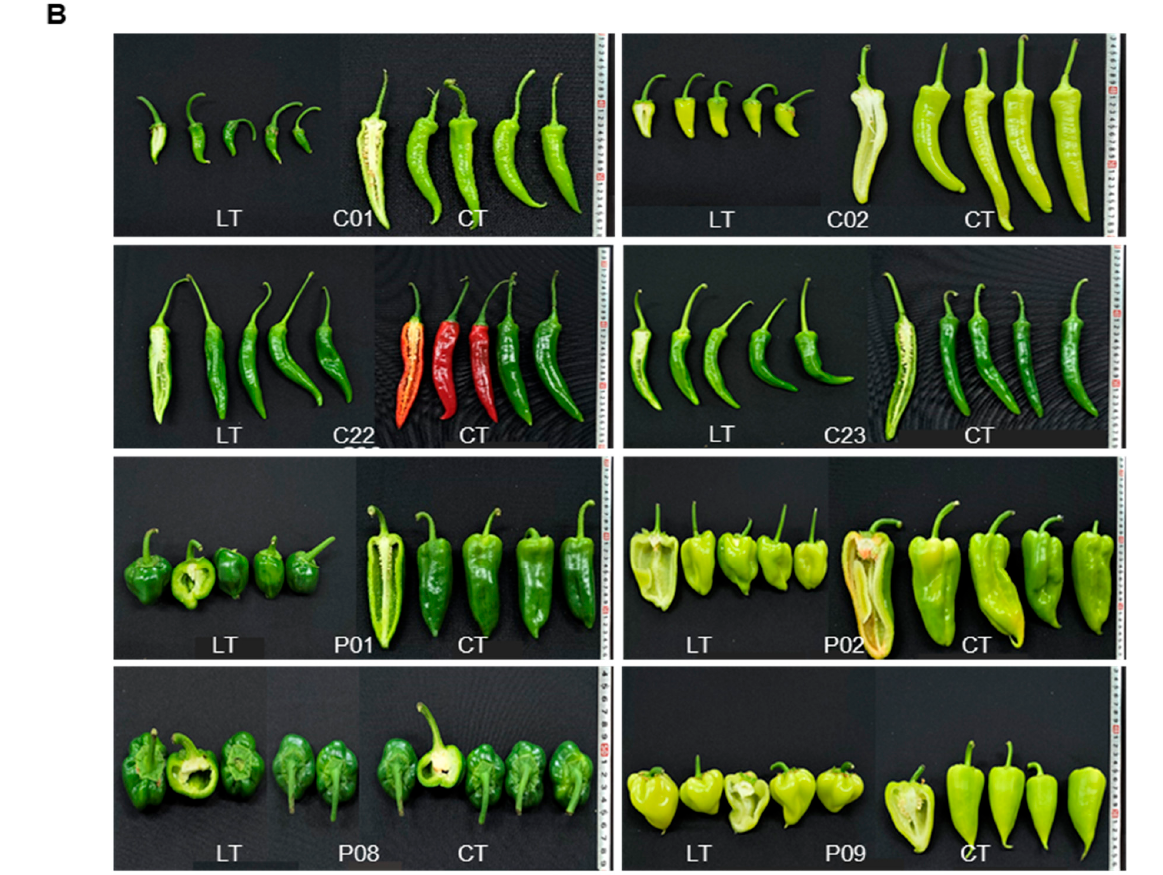
Figure 5. ( A ) Dendrogram was performed by the cluster analysis of 39 pepper accessions on the basis of the Euclidean distance using components factors 1 and factors 2. ( B ) Four pepper accessions in chili and bell pepper were selected and the pictures were shown in the fruits of pepper plants taken at 120 days between LT and CT greenhouse conditions.